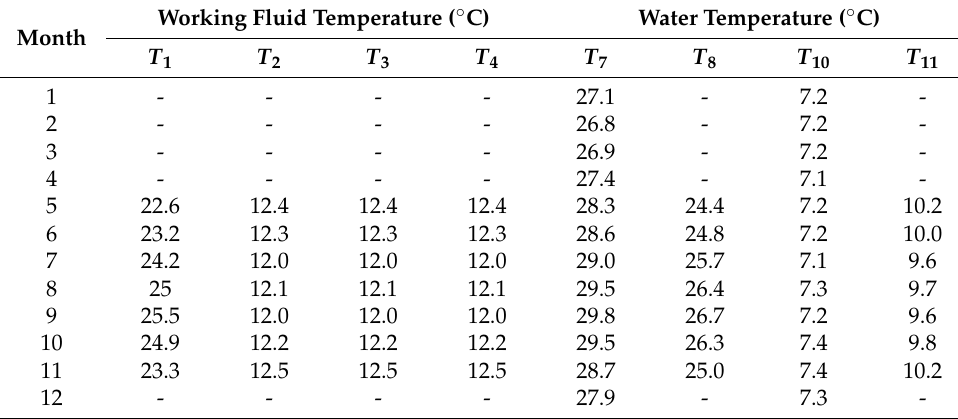
Table A1. Inlet and outlet temperature using HYCOM temperature data, considering 1 kWe of power